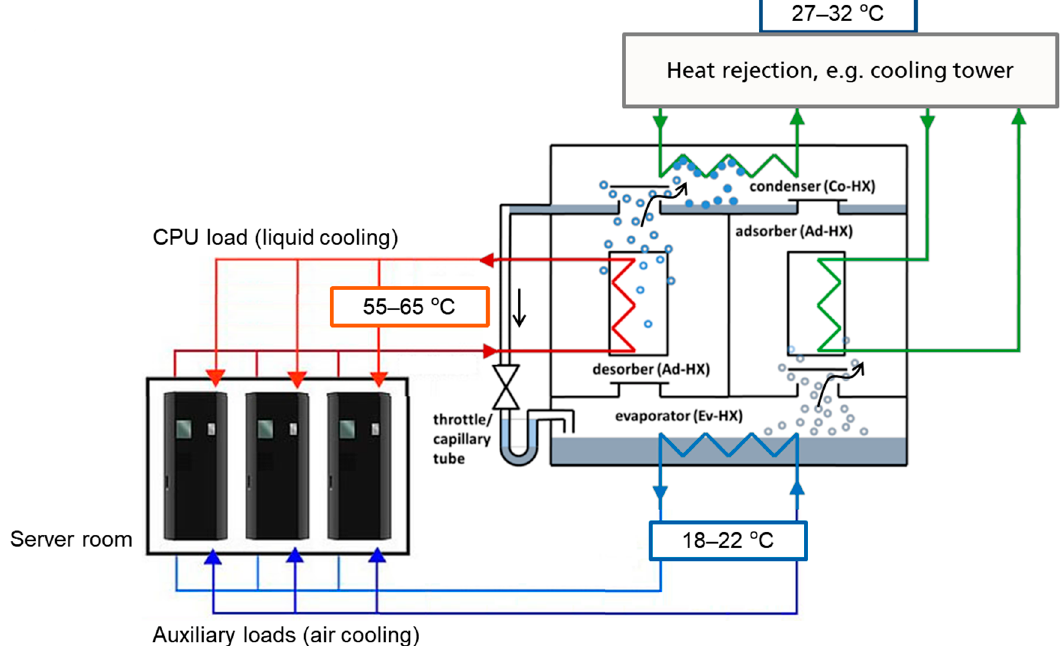
Figure 1. Working principle of an adsorption chiller for data centre cooling with typical feed and return temperature levels (schematic): high temperature CPU waste heat is yielded by direct water cooling and used to drive the adsorption chiller cycle, the chiller provides low temperature cooling for less temperature stable auxiliary loads (e.g., hard disks, power supplies), all heat flows are rejected at medium temperature level to the ambient, e.g., through a cooling tower.